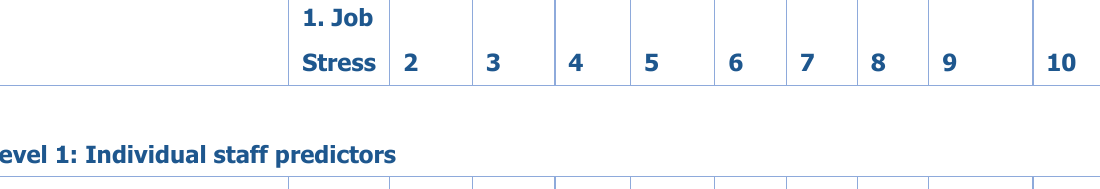
Table B1. Correlations Between Stress and Level-1 and Level-2 Predictor Variables 1.